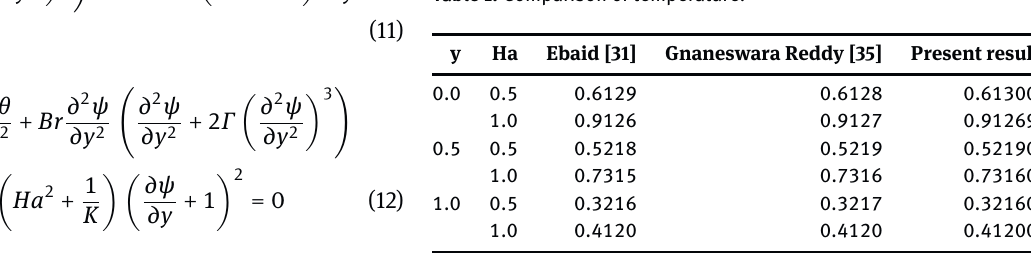
Table 1: Comparison of